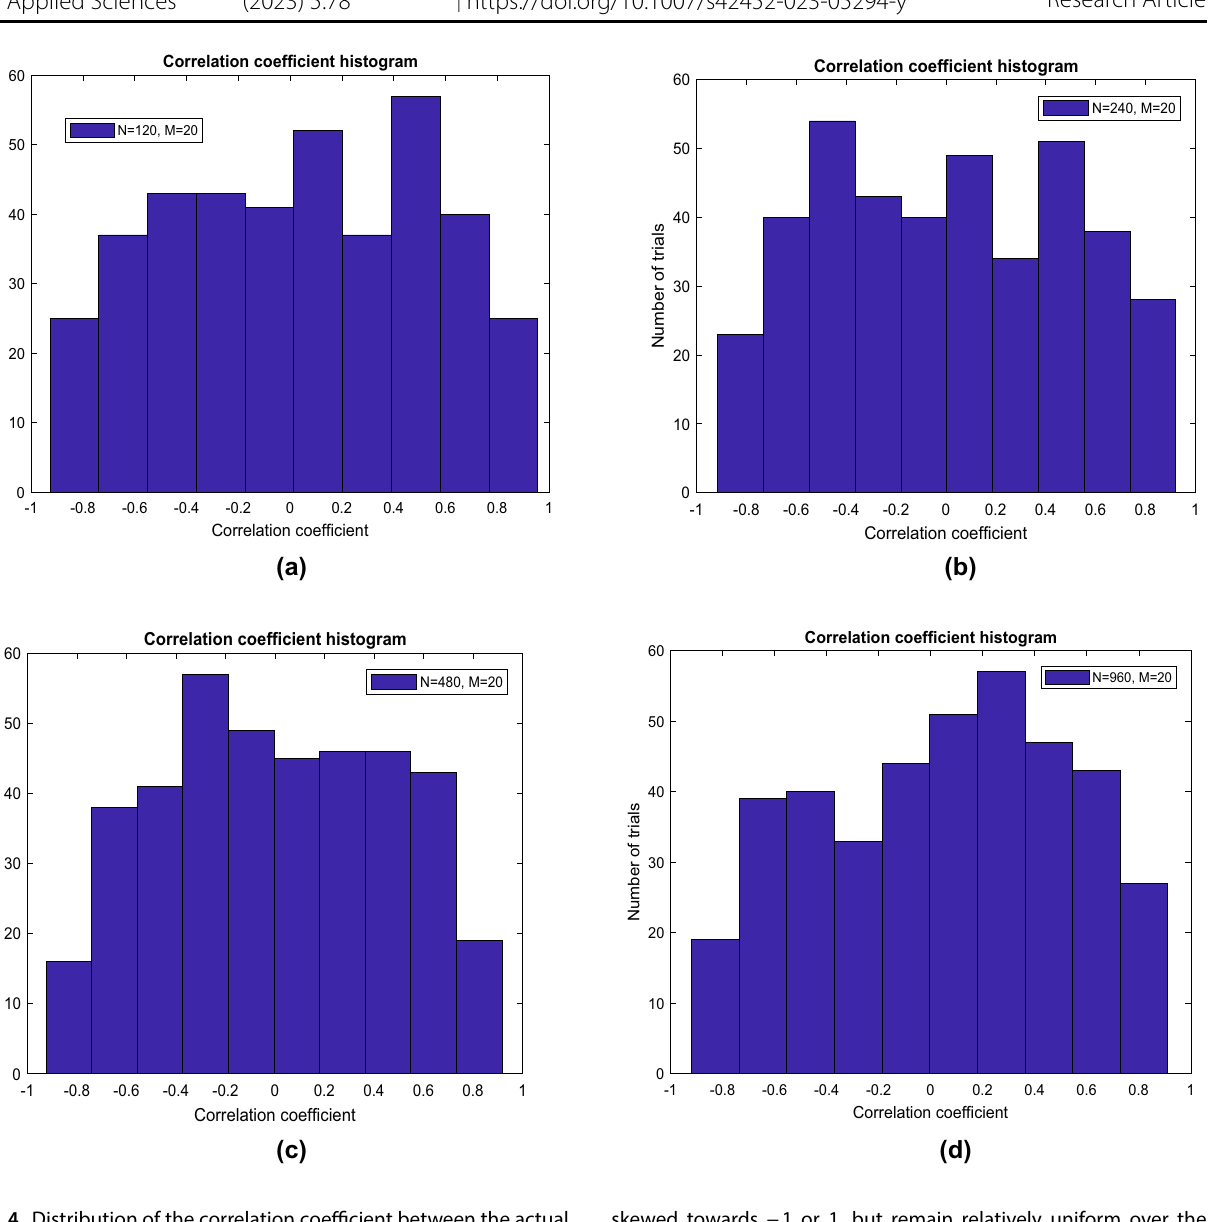
Fig. 4 Distribution of the correlation coefficient between the actual data and the estimated data for a N = 120, M = 20, b N = 240, M = 20, c N = 480, M = 20, d N = 960, M = 20. None of the distributions are